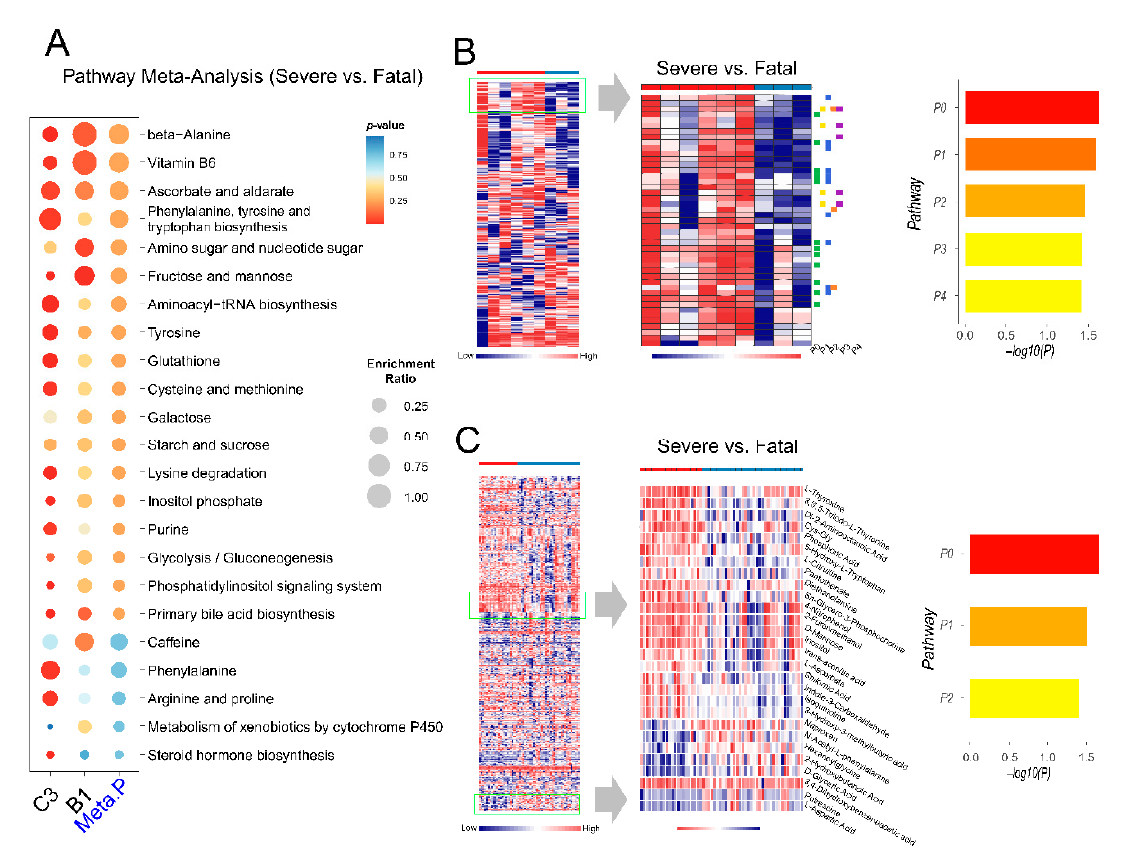
Figure 6. Pathway analysis and cluster heatmap analysis between severe and fatal groups. ( A ) Summary of pathway analysis and meta-analysis result. ( B ) Enrichment analysis on a metabolic pattern of interest in dataset B1 (positive ion mode). P0: Primary bile acid biosynthesis; P1: D-Glutamine and D-glutamate metabolism; P2: Steroid biosynthesis; P3: Ubiquinone and other terpenoid-quinone biosynthesis; P4: Alanine, aspartate and glutamate metabolism. The vertical dashed line in the bar plot is the threshold of p = 0.05. ( C ) Enrichment analysis on the combined metabolic patterns of interest in dataset C3. P0: Arginine biosynthesis; P1: Tyrosine metabolism; and P2: Pantothenate and Coenzyme A (CoA) biosynthesis.